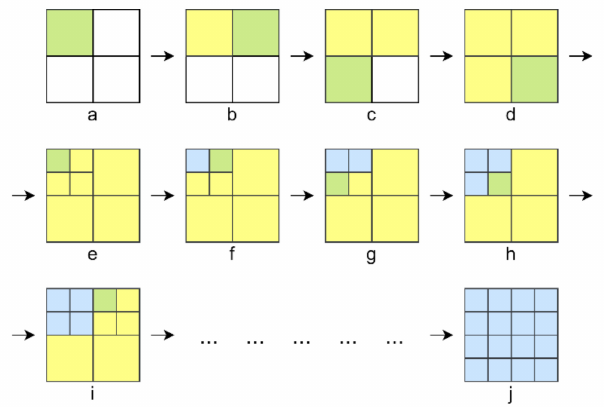
Figure 1. FEDA principle (based on [13]). This scheme shows phase optimization for 4 × 4 format. ( a – d ) Phase modulation of 4 segments of the initial phase matrix in the 2 × 2 format. ( e – h ) Division of the first segment into 4 equal sized segments and phase modulation for these smaller segments while having the optimized phase values set. ( i ) The procedure made in ( e – h ) is repeated for the second segment of the 2 × 2 initial phase format. ( j ) The remaining two segments follow the same steps until an optimized 4 × 4 phase matrix is achieved.